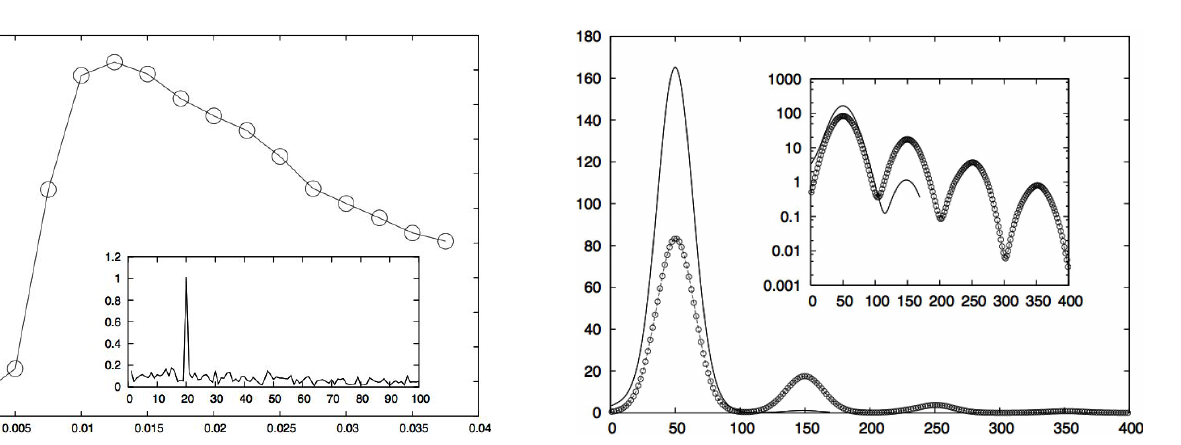
Fig. 6. Probability distribution of the random switching time τ for two different noise amplitude obtained as the solution of Eq. (7). The amplitude and the period of the forcing is the same. Line refers to σ R (see Fig. 5) while symbols refer to σ = 0 . 8 σ R . In the inset we show the probability distribution of the random switching time in log-lin plot. It is evident that for σ smaller than σ R the probability distribution of τ is “quantized” at integer values of ( 2 n + 1 )T/